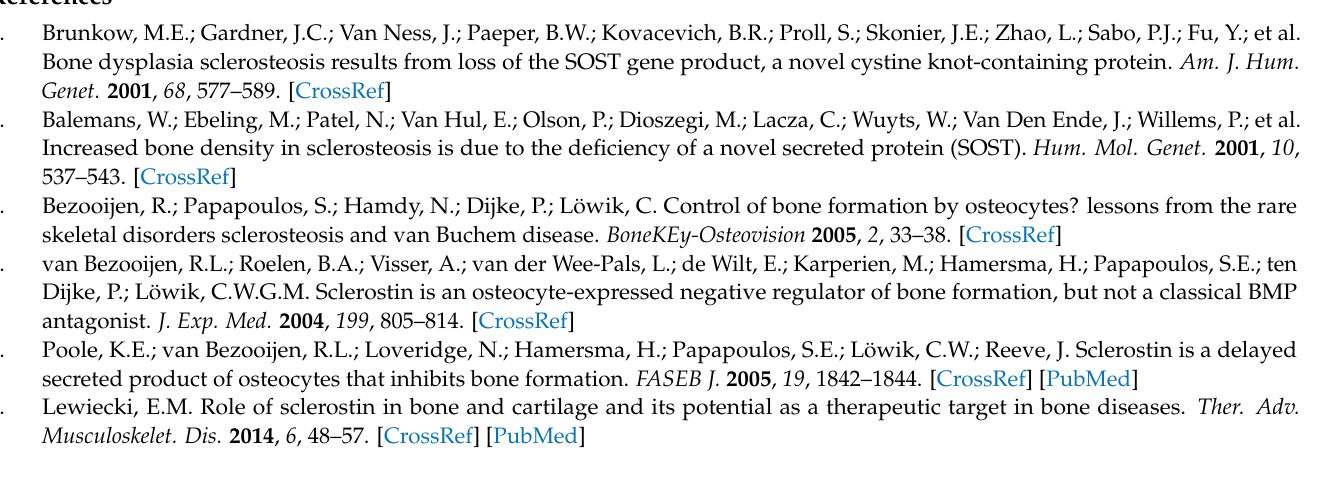
Table S15: Bone strength